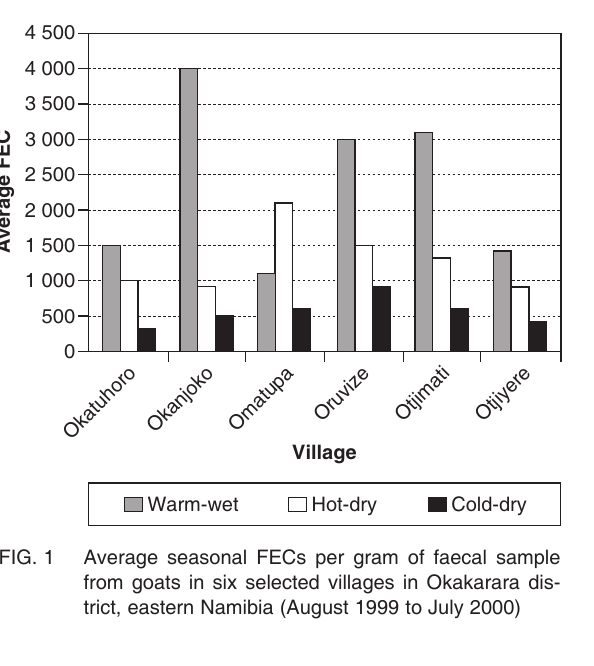
FIG. 3 Average monthly FECs per gram of faecal sample from goats in six villages in Okakarara district, eastern Na- mibia (August 1999 to July 2000). Note that low FECs were recorded in May through September, the cold-dry season. It is obvious that Strongyles were the main par- asite group found in goats in the